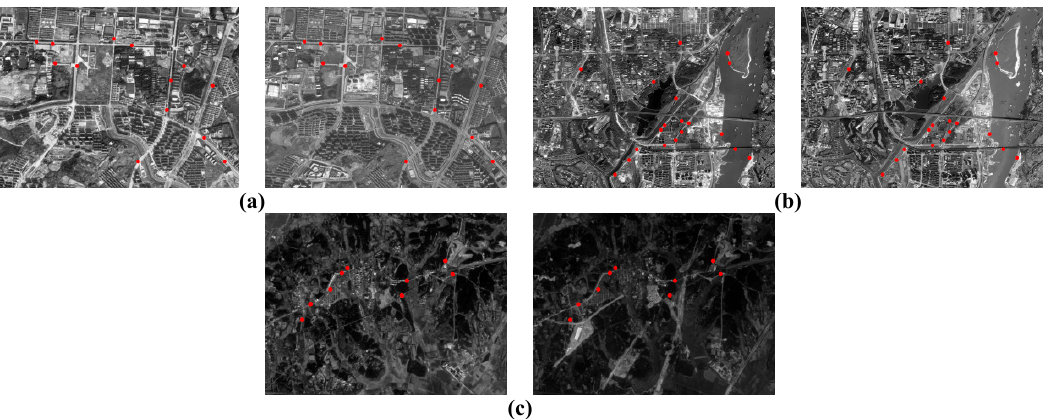
Figure 15. Matching results using Jiang’s method [5]. ( a – c ) are the matching results of Pairs 1–3. No correct match is obtained for the images of Pairs 4–6 (i.e., see Table 2).